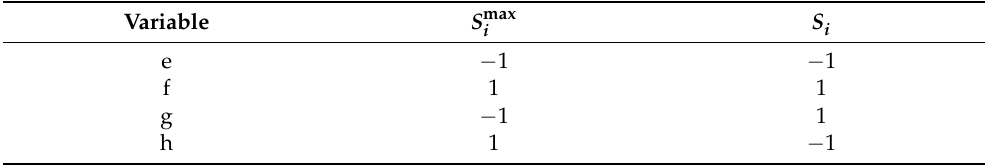
Table 5. Variables’ similarity index